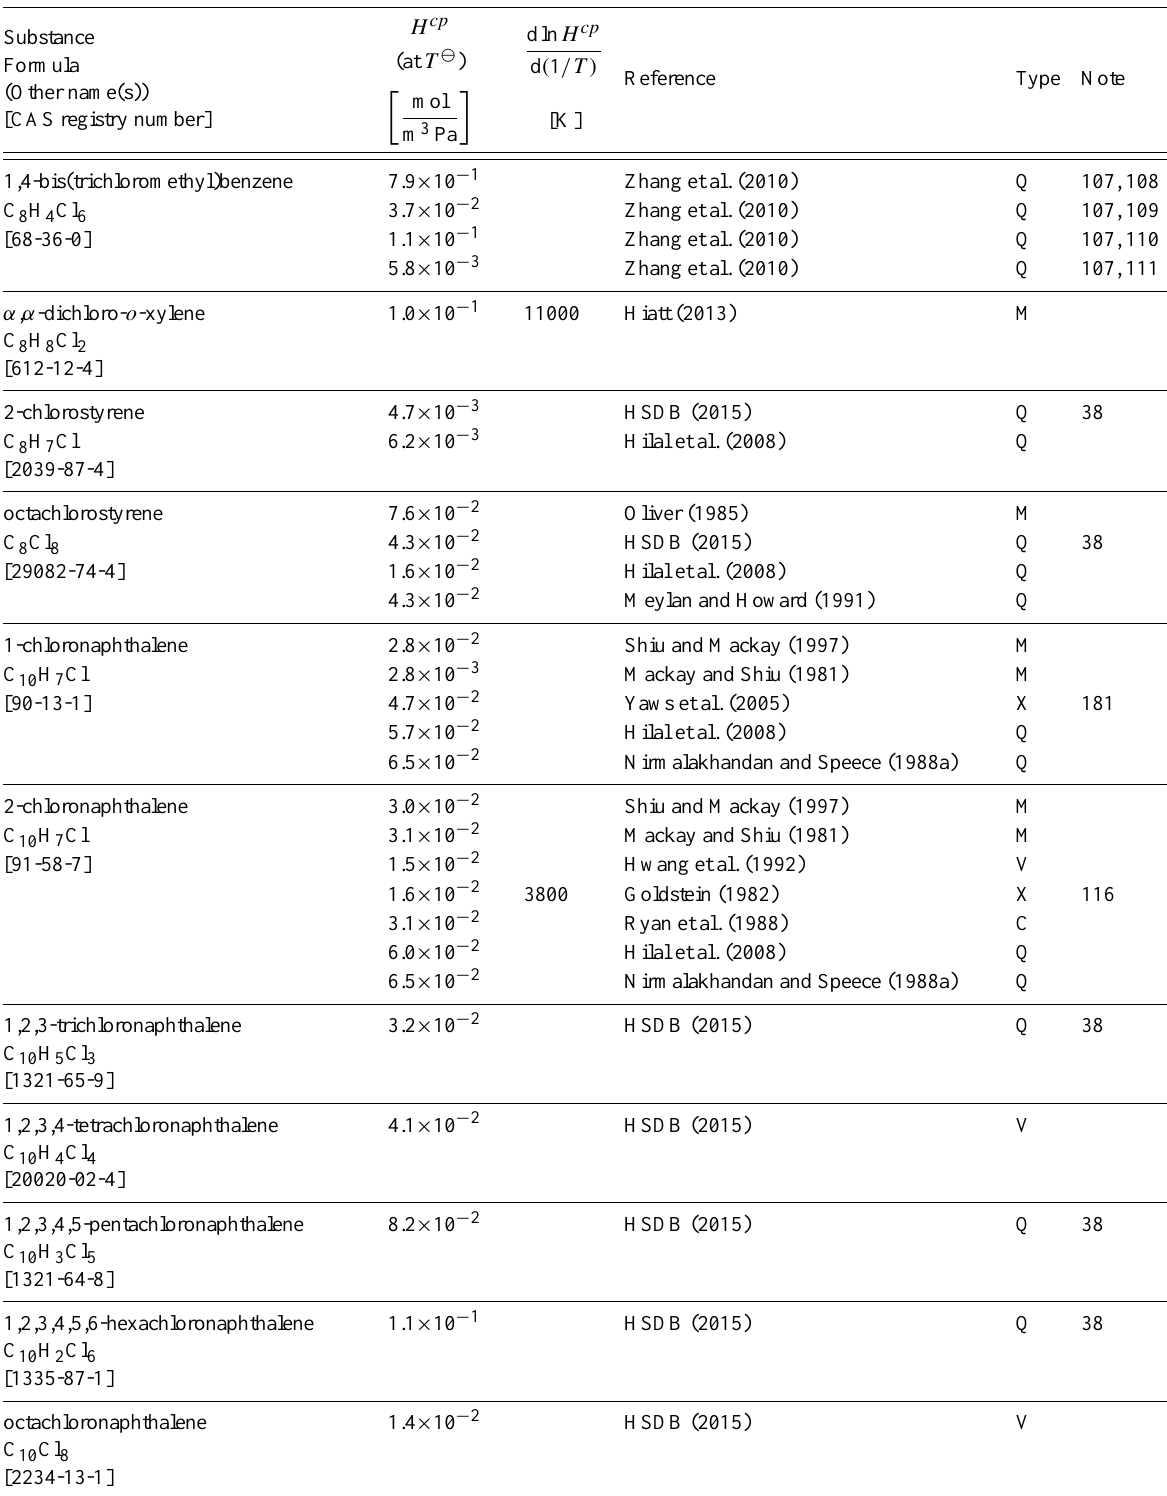
Table 6: Henry’s law constants for water as solvent